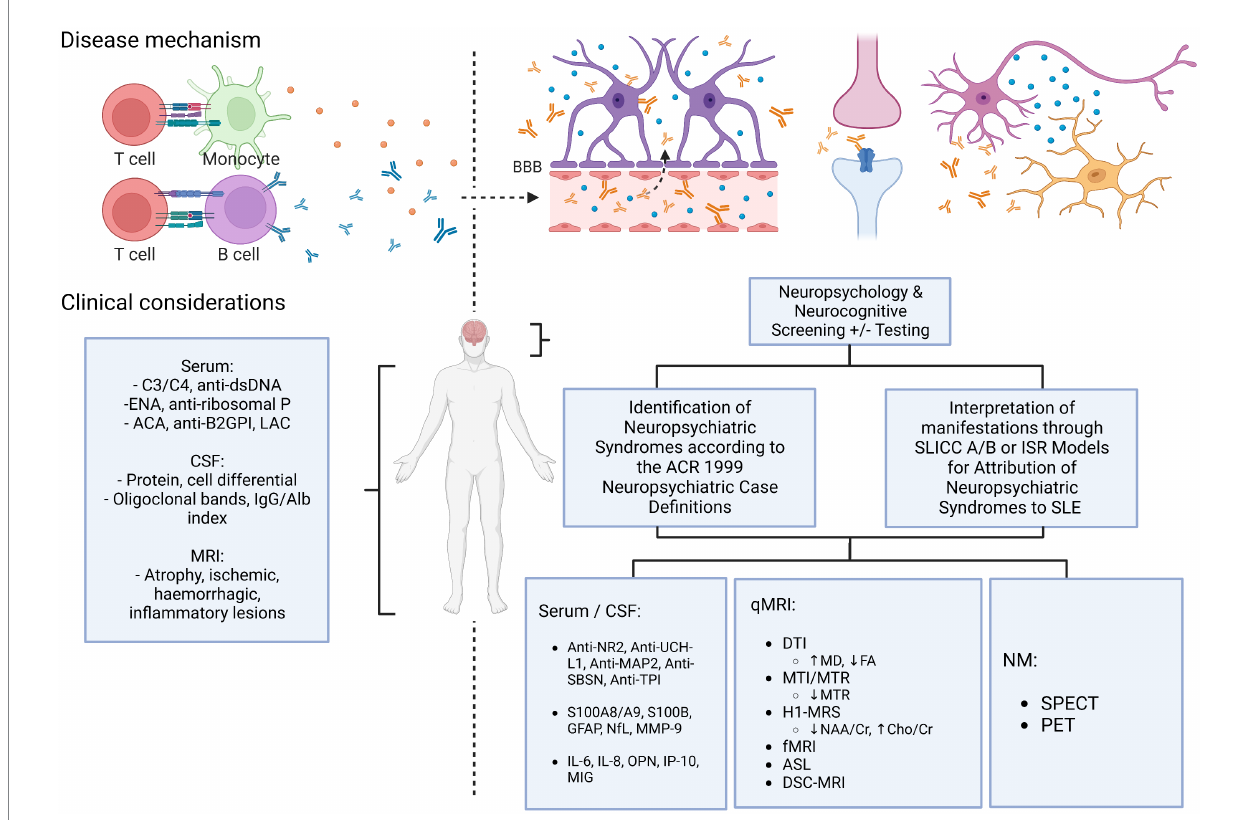
FIGURE 3 Current & proposed diagnostic algorithm in suspected NPSLE. ACA, anti-cardiolipin antibodies; ACR, American College of Rheumatology; anti- β 2GPI, anti-beta-2-glycoprotein I; ASL, arterial spin labelling; BBB, blood–brain barrier; Cho, choline; Cr, creatine; DSC, dynamic susceptibility contrast; DTI, diffusion tensor imaging; ENA, extractable nuclear antigens; FA, fractional anisotropy; fMRI, functional MRI; H1-MRS, magnetic resonance spectroscopy; ISR, Italian Society of Rheumatology; LAC, lupus anticoagulant; MD, mean diffusivity; MTI/MTR, magnetization transfer imaging/ratio; NAA, N-acetyl aspartate; NM, nuclear medicine; qMRI, quantitative MRI; SLICC, Systemic Lupus International Collaborating